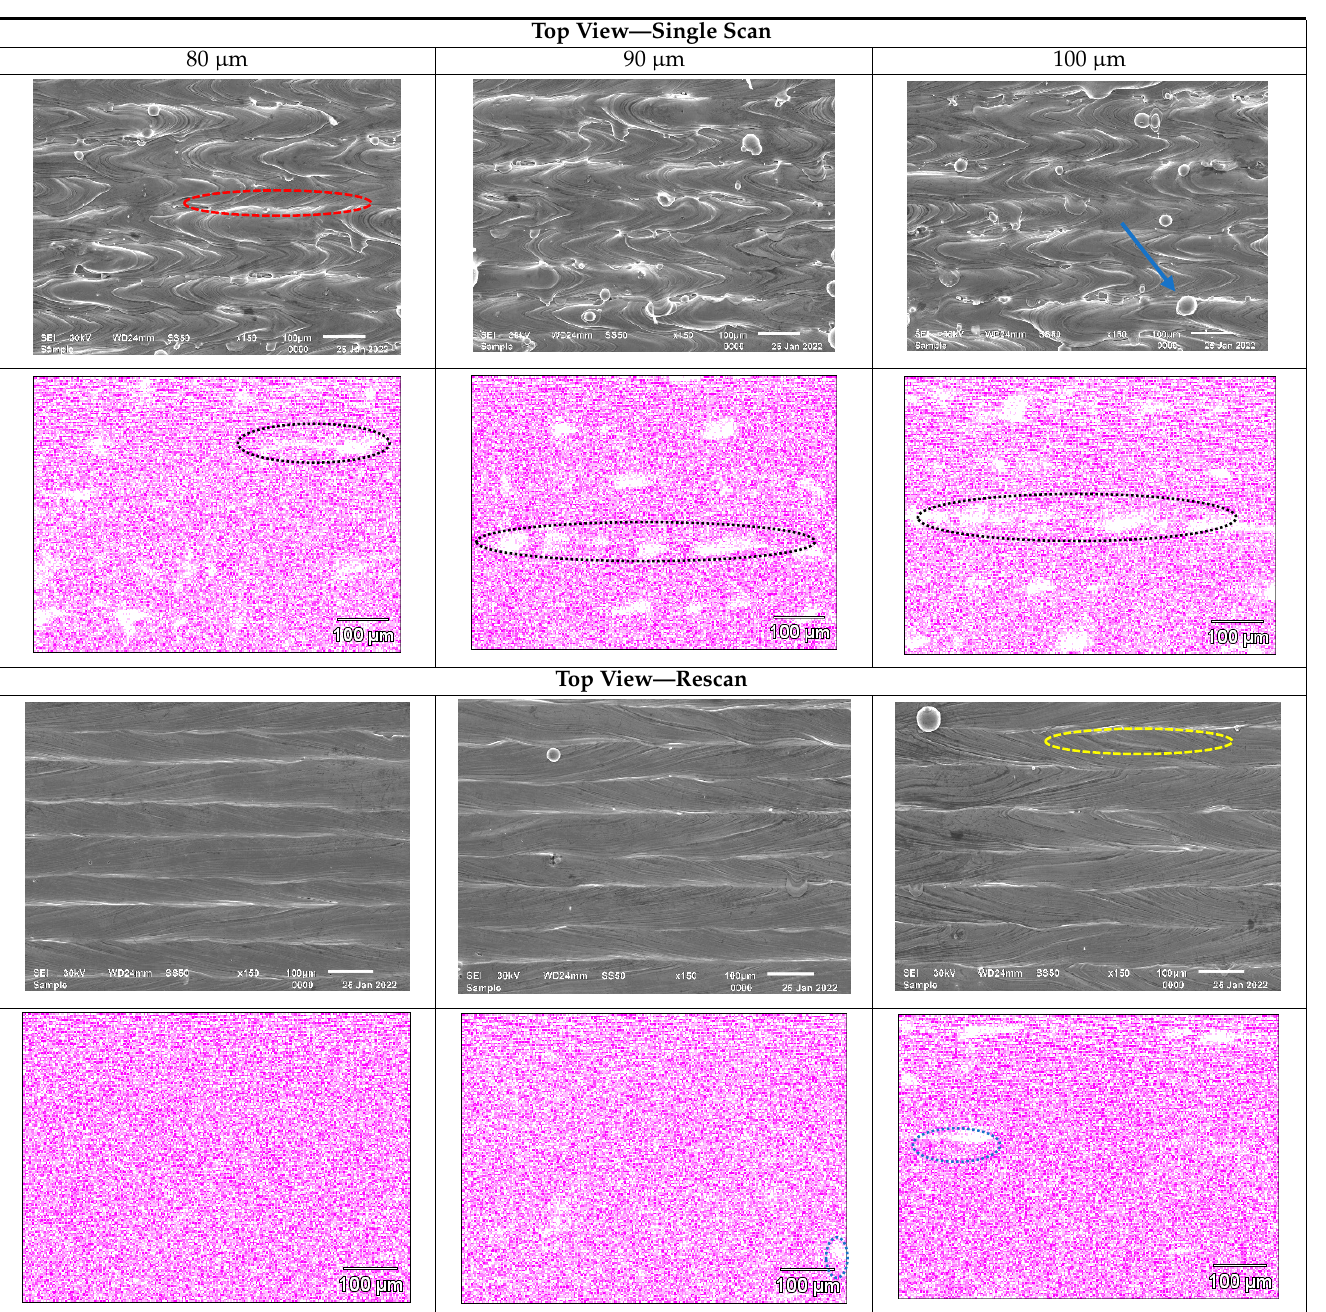
Table 2. Surface morphology and Mo distribution map by EDS of the Ti5Mo double layers with different scanning strategies and hatch distances.